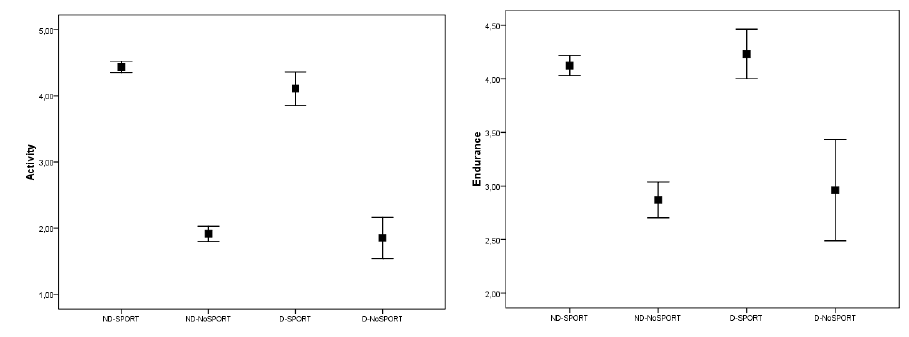
Figure 1 95% Confidence Interval Graphs for PSDQ Scales in the four